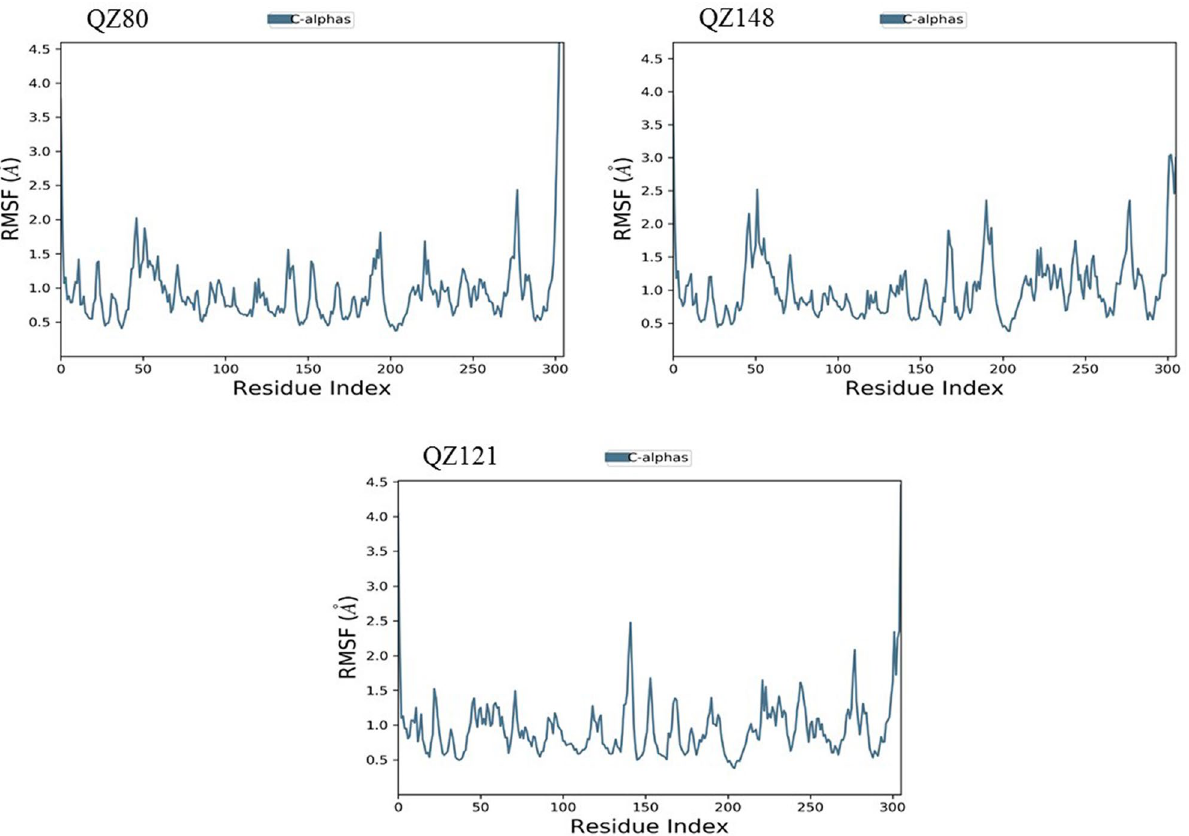
Figure 11. Root mean square fluctuation (RMSF) plots for docked complexes of QZ-M pro